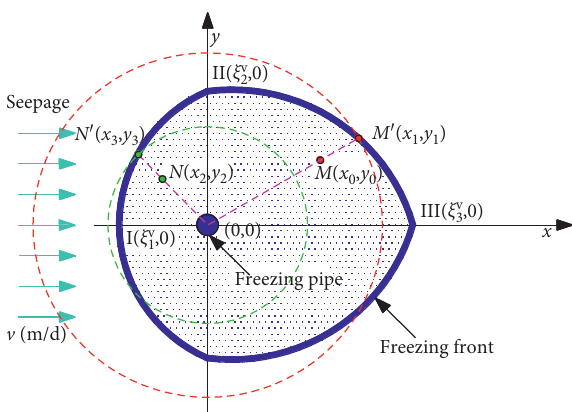
Figure 1: Schematic diagram of the mathematical model of steady- state temperature field of a single freezing pipe under the action of seepage